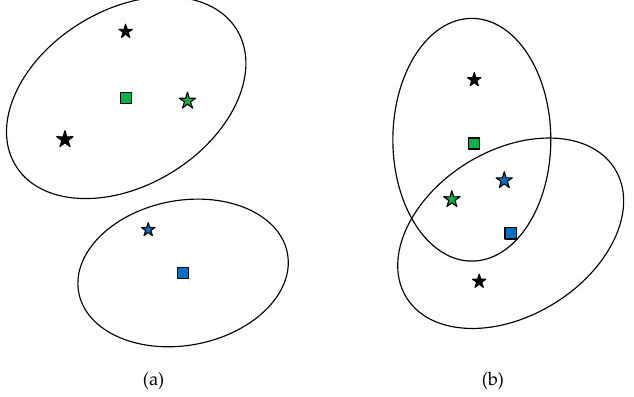
Figure 5. Examples of associations between targets and measurements for ( a ) standard point target tracking case and ( b ) group target tracking case. The square represents the target, distinguished by different colors. Measurements include clutter (black hexagrams) and target measurements (hexagrams in other colors). The ellipse is the correlation threshold. Note that a target is only associated with measurements fall within its threshold.